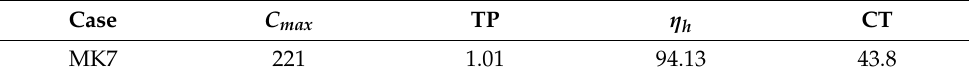
Figure 13. Equipment Gantt Chart for the Production Scheduling Results of Case MK7. Table 5. A non-dominated optimization target value and running time of MK7.